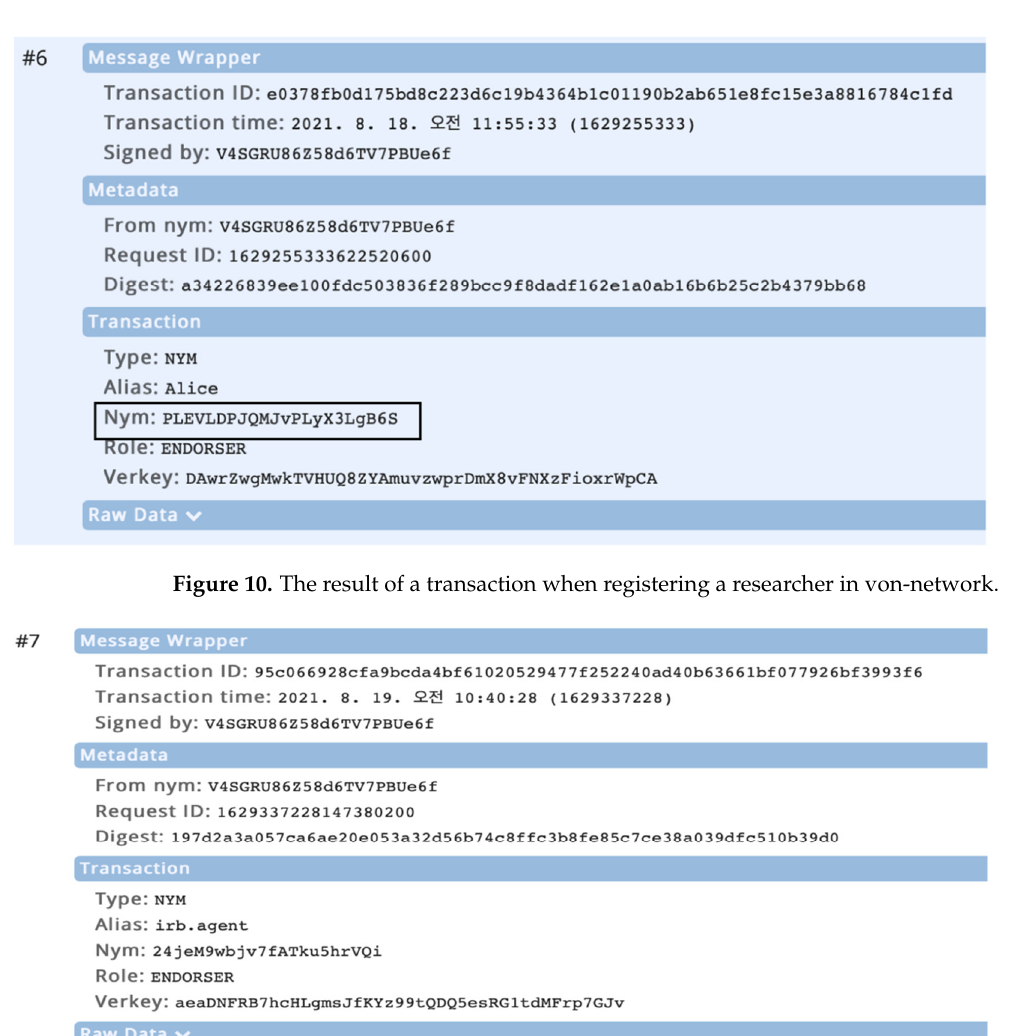
Figure 11. The result of a transaction when registering IRB in von-network.